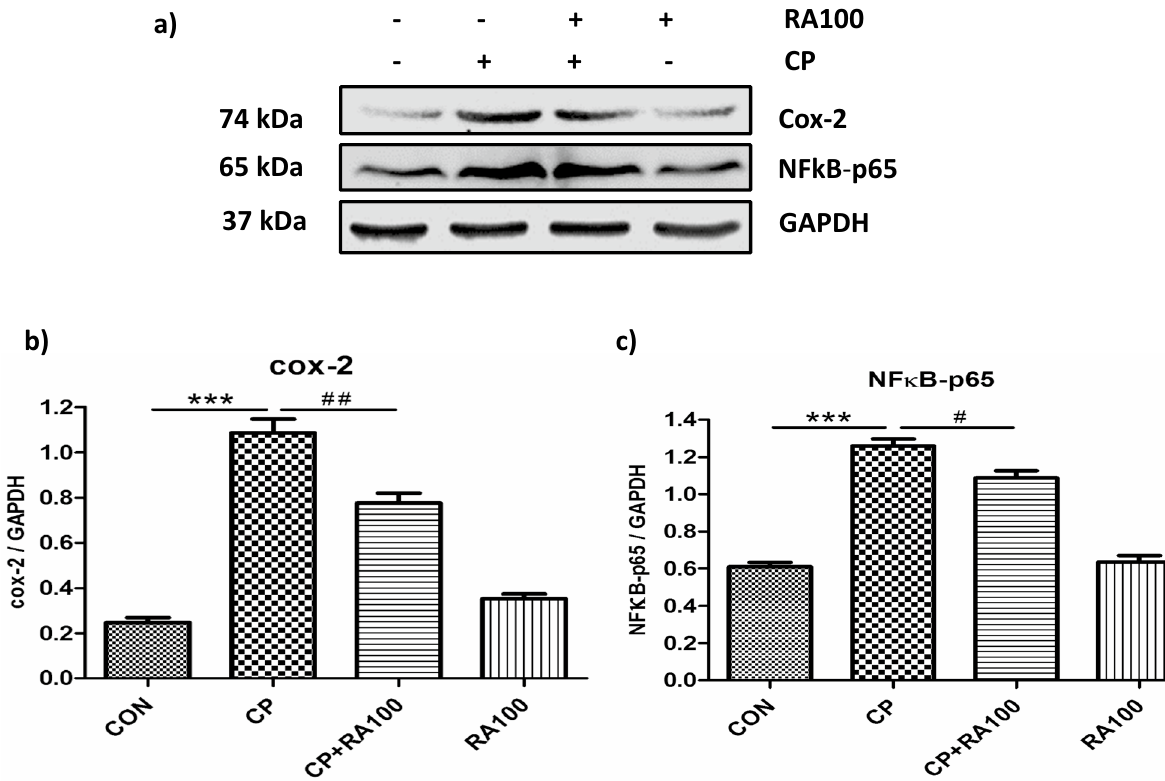
Figure 6. Western blotting analysis of inflammatory markers. Effect of RA and CP on the expression of COX-2 and NFκB-p65 in mouse kidney tissue as studied by western blot analysis is shown in ( a ) by immunoblots of inflammatory markers COX-2 and NFκB-p65. The administration of CP caused an increase in the expression of COX-2 and NFκB-p65 proteins when compared with control group of animals. While the treatment of RA along with the administration of CP decreases the expression of COX-2 and NFκB-p65 proteins when compared with CP alone treated group of mice. In this figure histograms ( b ) and ( c ) represent significant